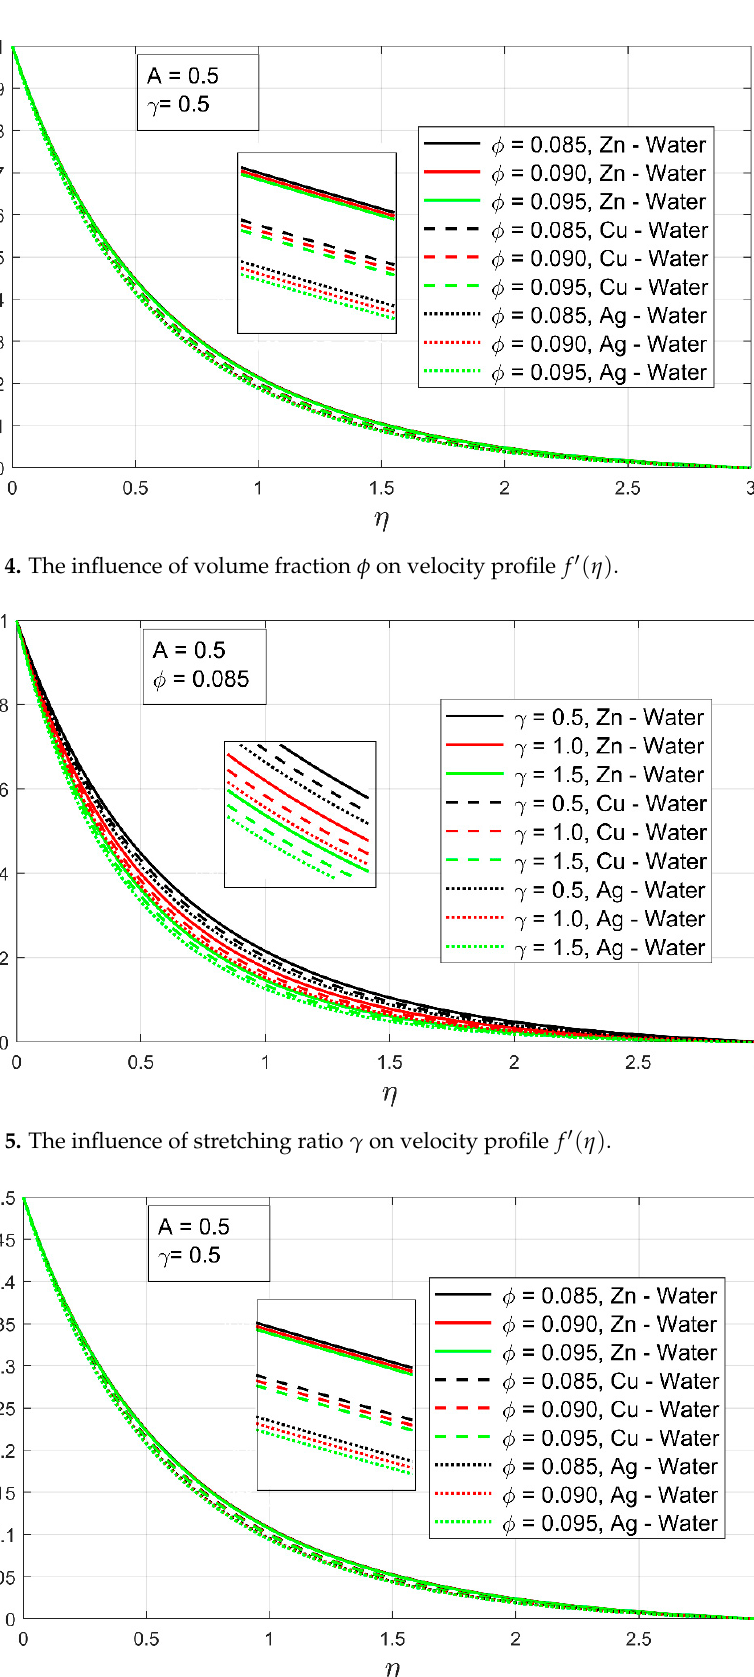
Figure 7. The influence of stretching ratio (cid:2011) on the velocity profile (cid:1859) (cid:4593) ((cid:2015)) .